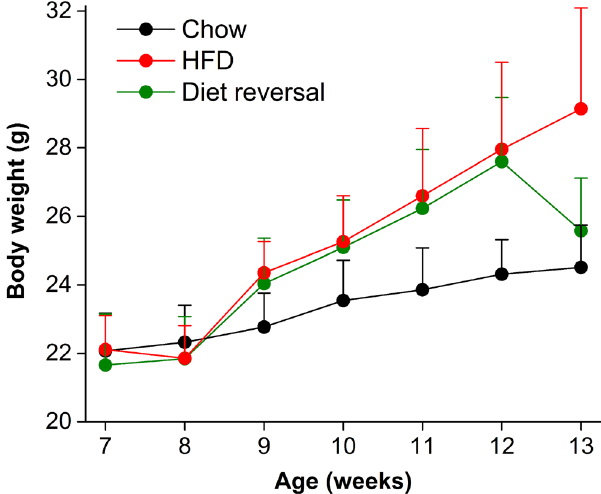
Fig 2. Diet-induced obesity is rapidly reversed. Weekly body weights (mean grams ± SD) of male heterozygous PER2::LUC mice fed either chow for 5 weeks (black circles), high-fat diet for 5 weeks (red circles), or high-fat diet for 4 weeks and then chow for 1 week (green circles).